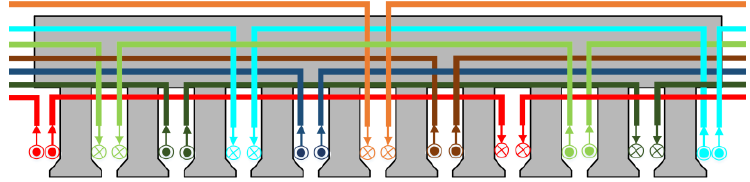
Figure 2. Winding pattern for N P = 6, N S = 42 (q = 1).